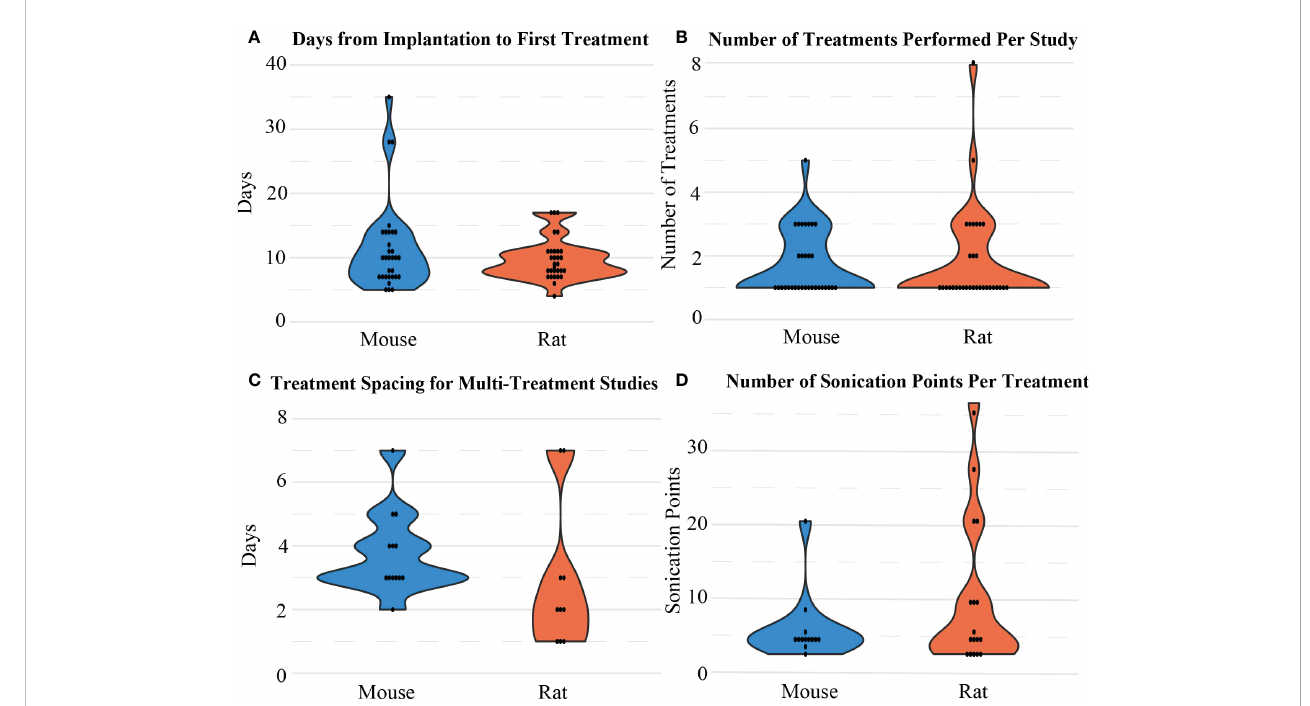
FIGURE 6 Distribution of (A) the time intervals between implantation and the fi rst BBB opening treatment, (B) the number of sonication treatments performed, (C) the treatment spacing/interval considered between 2 treatment sessions, and (D) the number of sonication points considered in one treatment session for mice and rat